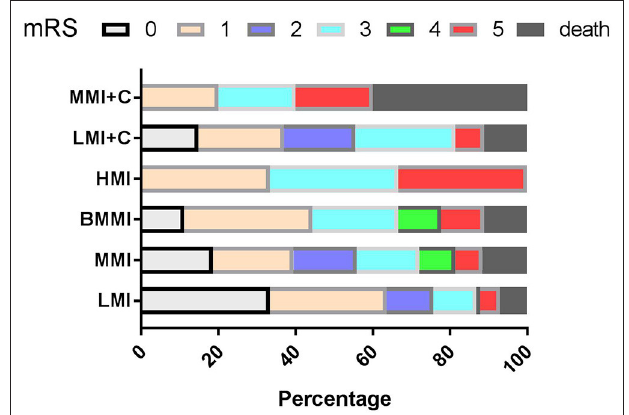
FIGURE 3 | mRS according to the types of MI during follow-up. mRS, modified Rankin Scale; LMI, lateral MI; MMI, medial MI; LMI + C, LMI + cerebellar infarction; MMI + C, MMI + cerebellar infarction; BMMI, bilateral MI; HMI, hemimedullary